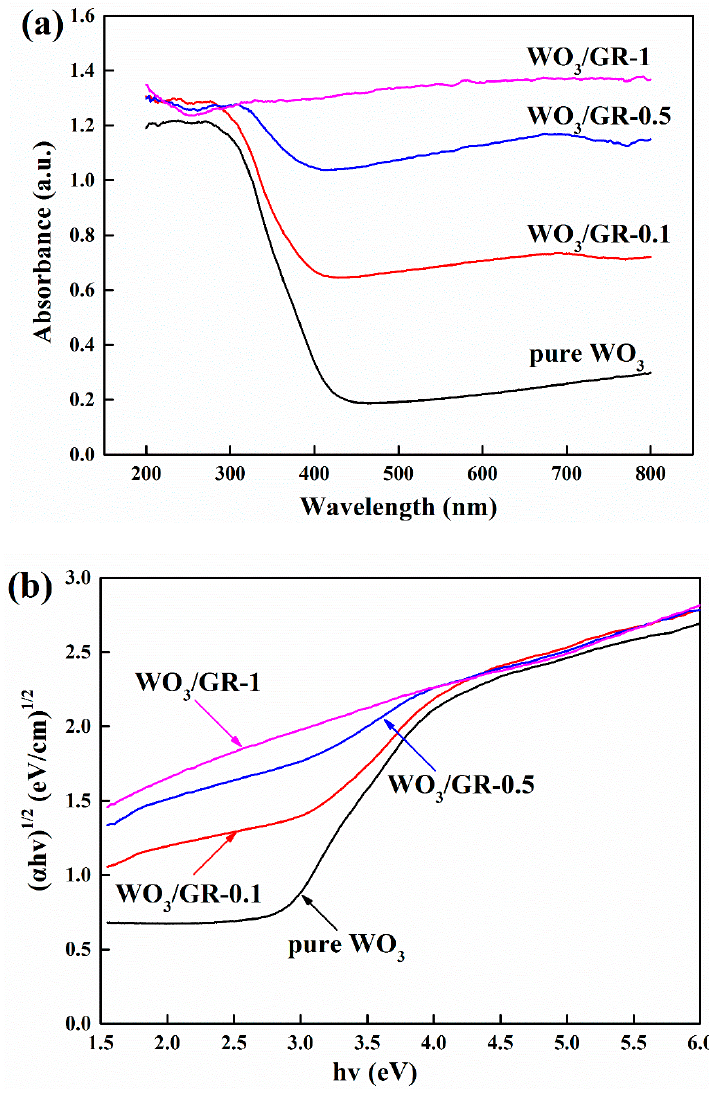
Figure 8. ( a ) UV–vis diffuse reflectance electronic spectra of pure WO 3 and the WO 3 /GR nanocomposites; and ( b ) the relation curves of h v and corresponding ( α h v ) 1/2 of the as-prepared samples.